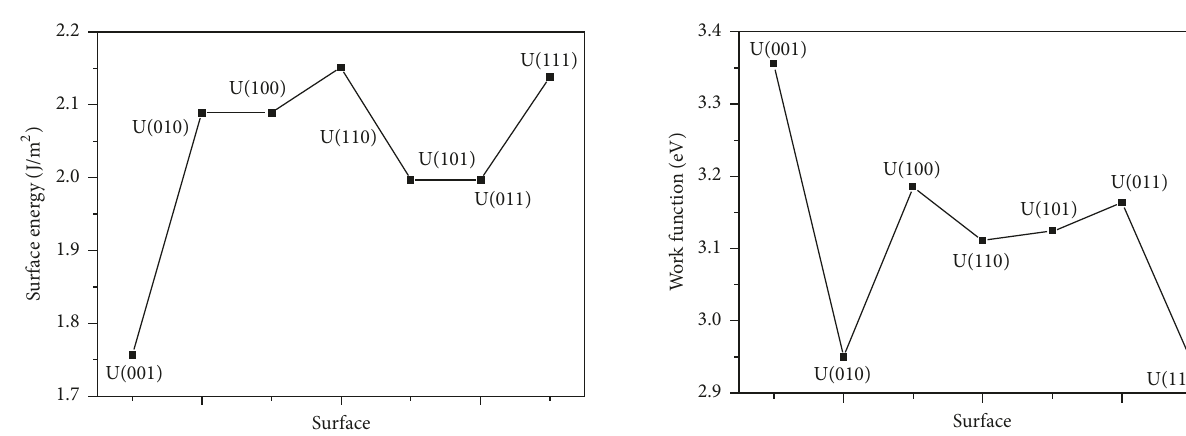
Figure 7: Variation of work functions of seven basic uranium